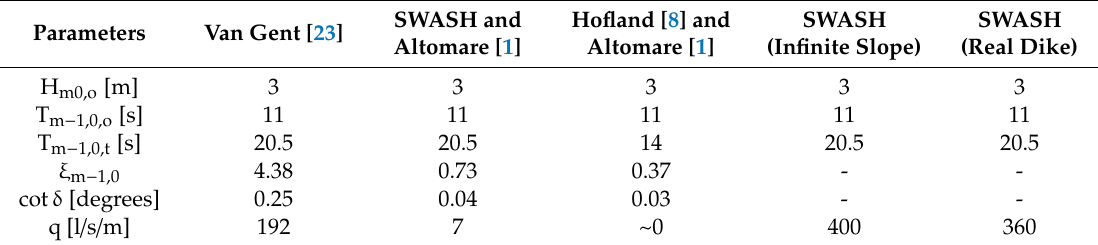
Table 5. A comparison of various approaches in the shallow water case (h toe /H m0,o = 1). SWASH and Hofland [8] Van Gent [23] Parameters Altomare [1]